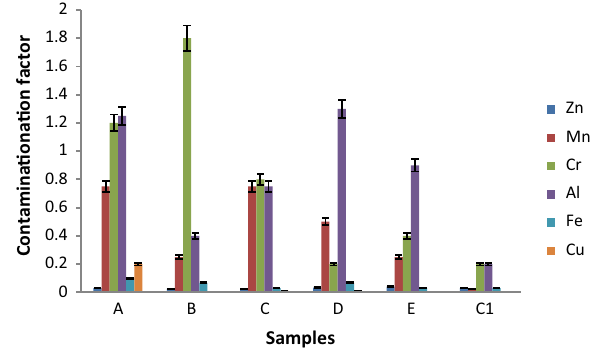
Fig. 3 Contamination factor of individual metals in borehole water samples Table 9 Water quality index of borehole water